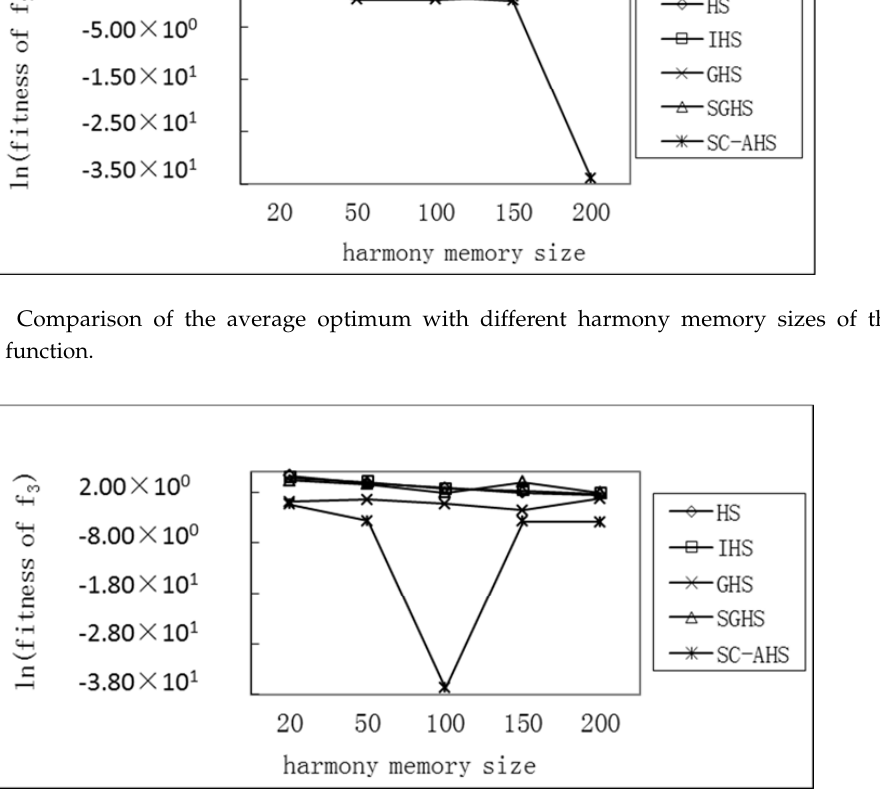
Figure 9. Comparison of the average optimum with different harmony memory sizes of the Griewank function. Information 2018 , 9 , x